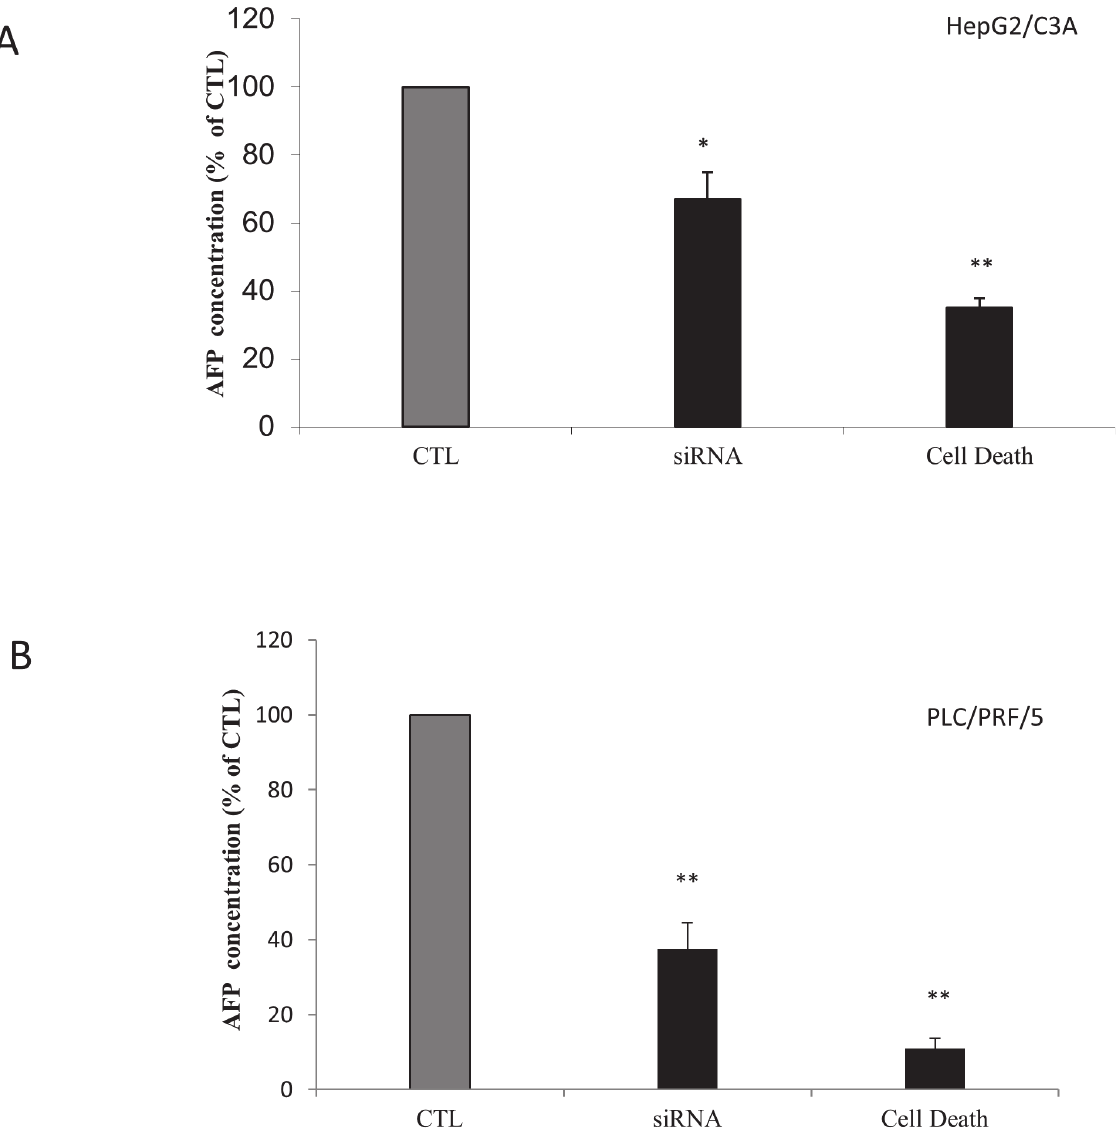
Fig 3. Effect of telomerase siRNA transfection on AFP production by HepG2/C3A and PLC/PRF/5 cells. The cells were seeded in 96-well plates in 100 μ L of DMEM with FBS at a density of 2x10 4 cells/well. Before seeding, the cells were treated with TransFectin and 20 nM specific siRNA or a mix of siRNAs vital for cell survival. The control received the vehicle. After incubation, 50 μ L of the supernatant was collected and tested by ELISA for AFP quantification. (A) The inhibition of telomerase by hTERT siRNA induced a decrease in AFP production by HepG2/C3A cells. (B) The same pattern was observed in the supernatants of PLC/PRF/5 cells. Each value was normalized to its own control, which was set to 100%. The data represent the means ± SD from three different experiments. * P < 0.01 versus untransfected cells. ** P < 0.005 versus untransfected cells.